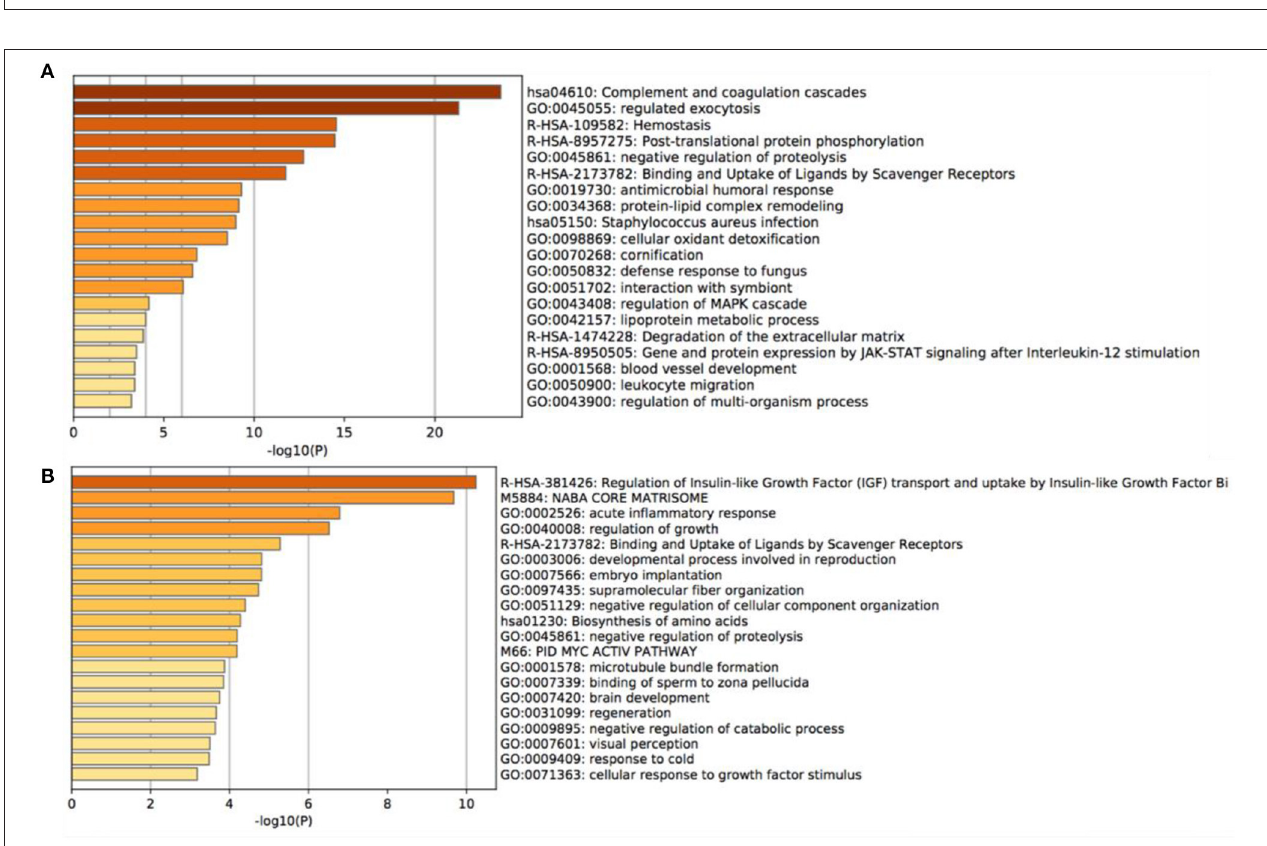
FIGURE 3 | Gene Ontology enrichment analysis of the main altered proteins. (A) the most notable 20 GO annotations of the increased proteins, (B) the most notable 20 GO annotations of the decreased proteins.